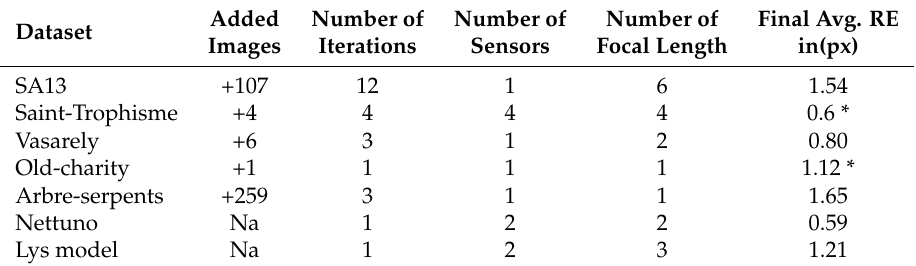
Table 2. Details of multimodal dataset enrichment and results of incremental processing. Added Number of Number of Number of Final Avg. RE Dataset Images Iterations Sensors Focal Length